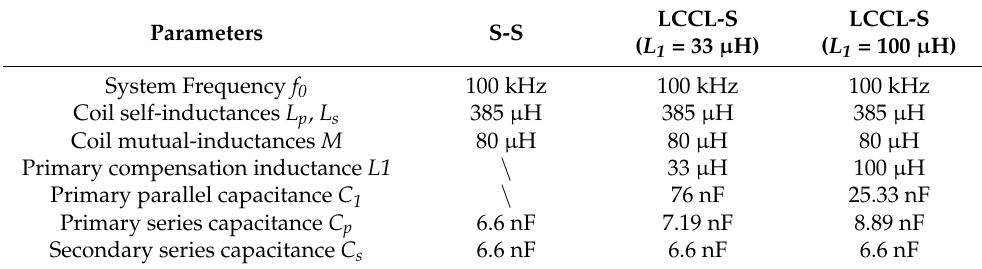
Figure 6. FBI output current/voltage waveformes and ZVS condition of ( a , d ) LCCL-S with L 1 = 33 μ H, ( b , e ) LCCL-S with L 1 = 100 μ H, and ( c , f ) S-S.